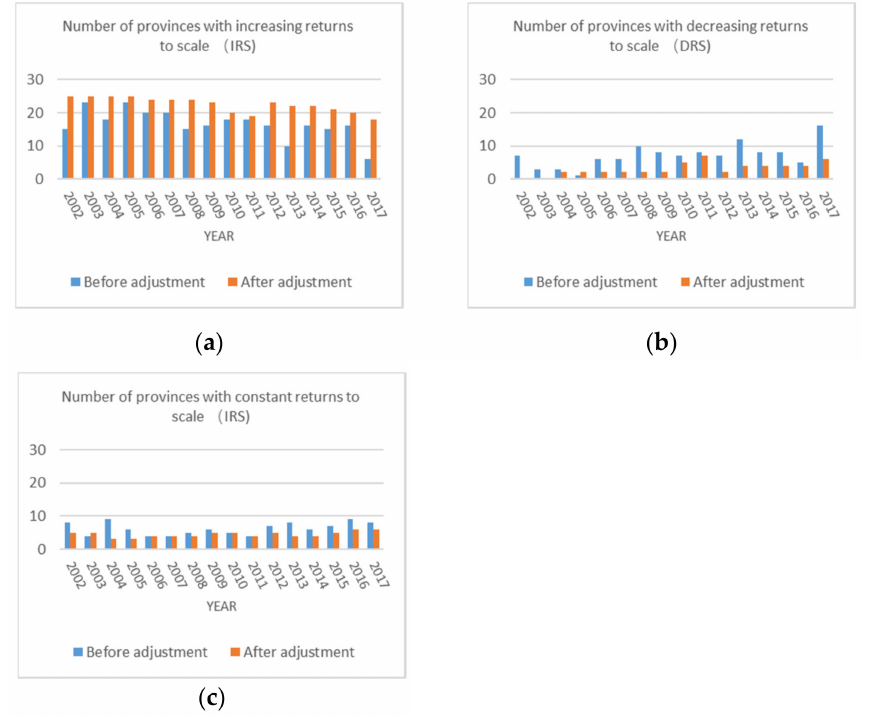
Figure 5. The number of provinces at increasing returns to scale, decreasing returns to scale and constant returns to scale,